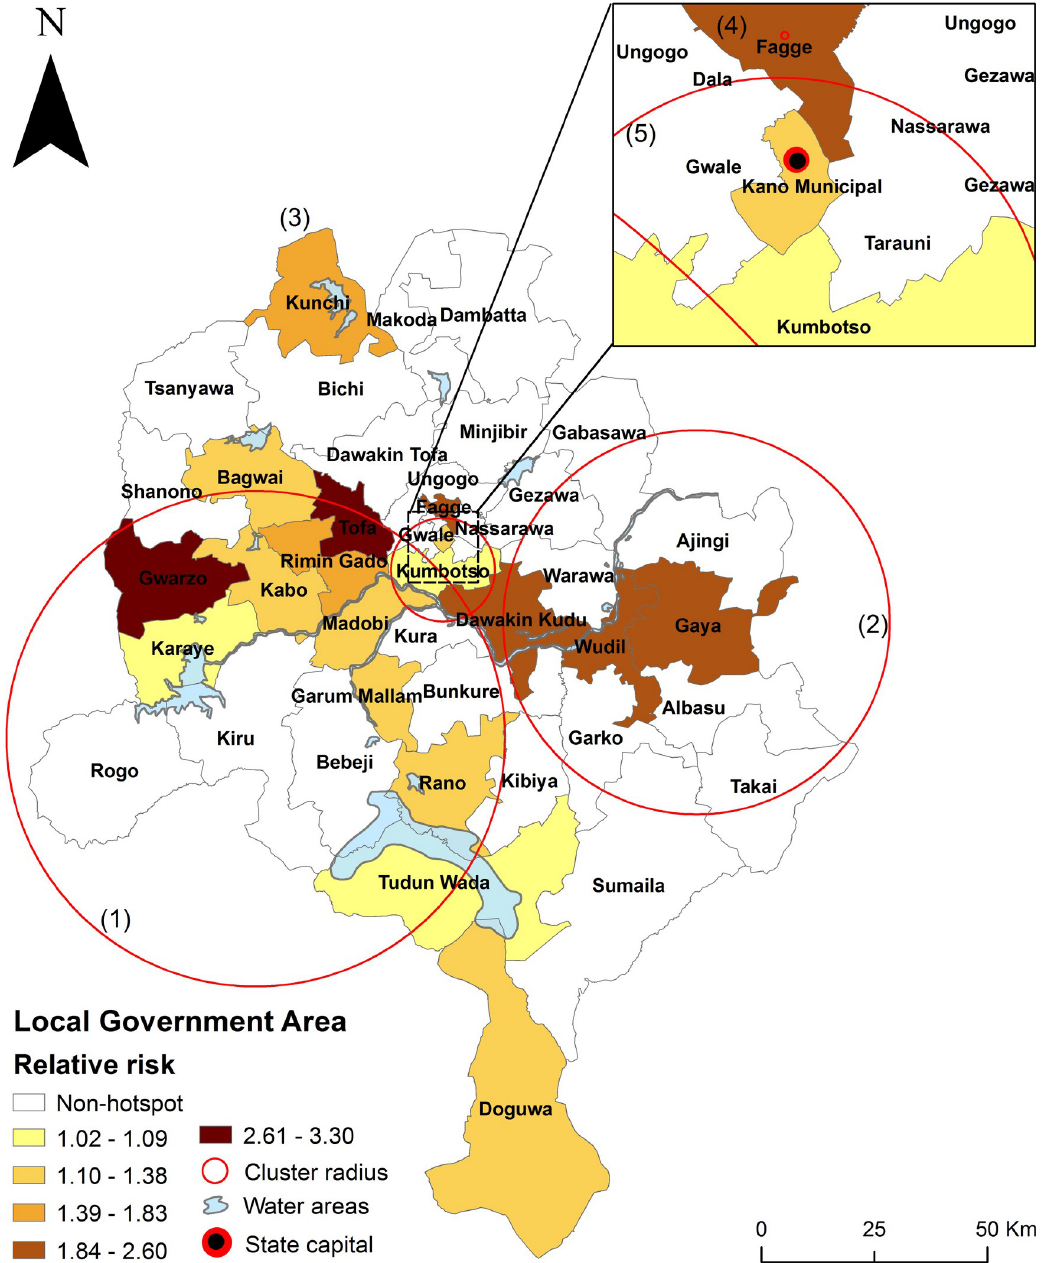
Fig 5. Statistically significant cholera hotspots Local Government Areas (LGAs) in Kano State, 2010–2019. Map depicts statistically significant relative risk (RR) per LGA for the cholera clusters (hotspot LGAs), i.e., LGAs within clusters with RR > 1. The LGA’s specific RR was calculated within each cluster using space-time scan statistics incorporating reported cholera cases and the population of the LGA for each year. Here cholera hotspot LGA means a geographically limited area where environmental, cultural and/or socioeconomic conditions facilitate the transmission of the disease and where cholera persists or reappears regularly. The insert shows a better view of the three urban hotspot